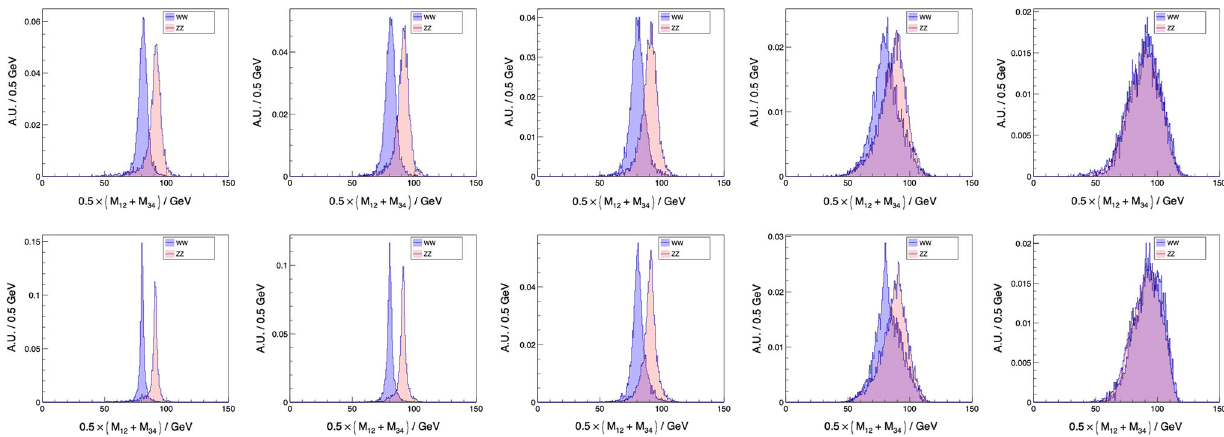
Fig. 18 The average di-jet mass distributions after dividing the inclu- sive sample into five subsamples. From left to right, the α is degrading. The distributions in the top row are using the RecoJets, the overlap- ping fraction is 24 . 8% ± 0 . 81%, 27 . 6% ± 0 . 77%, 39 . 1% ± 0 . 63%,